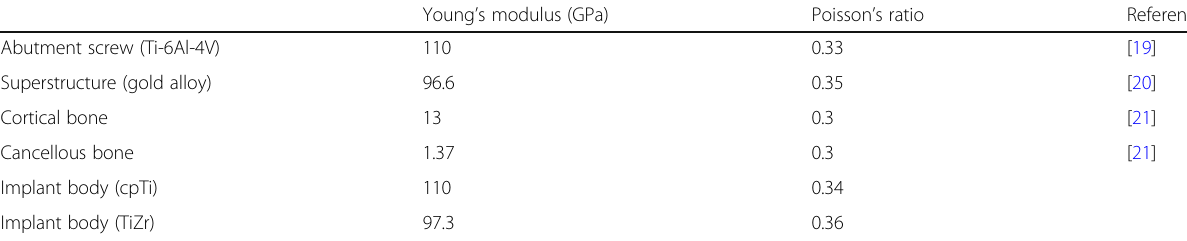
Table 1 Mechanical properties of each model